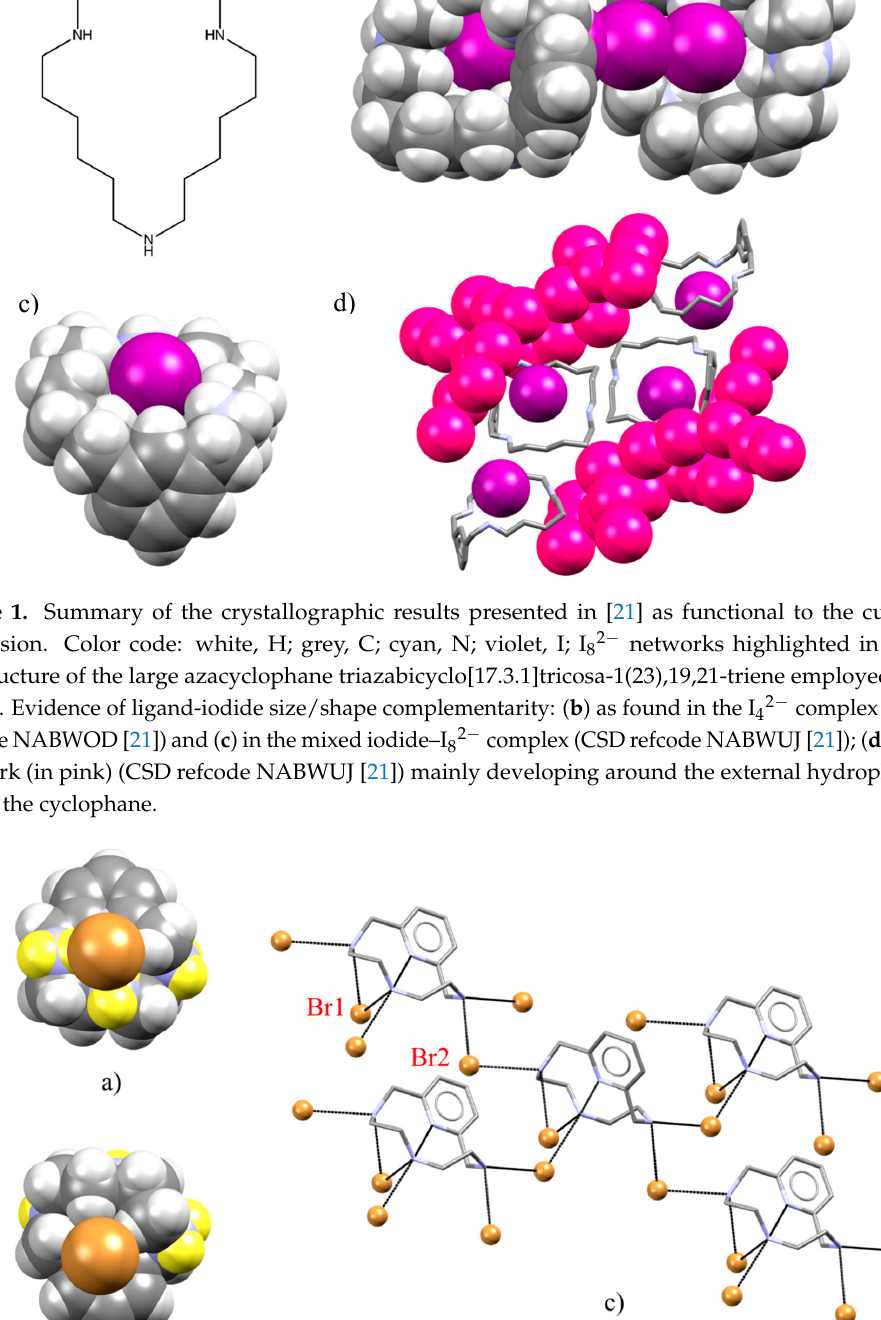
Figure 1. Summary of the crystallographic results presented in [21] as functional to the current discussion. Color code: white, H; grey, C; cyan, N; violet, I; I 82 − networks highlighted in pink. ( a ) Structure of the large azacyclophane triazabicyclo[17.3.1]tricosa-1(23),19,21-triene employed as a ligand. Evidence of ligand-iodide size/shape complementarity: ( b ) as found in the I 42 − complex (CSD refcode NABWOD [21]) and ( c ) in the mixed iodide–I 82 − complex (CSD refcode NABWUJ [21]); ( d ) I 82 − network (in pink) (CSD refcode NABWUJ [21]) mainly developing around the external hydrophobic rim of the cyclophane.